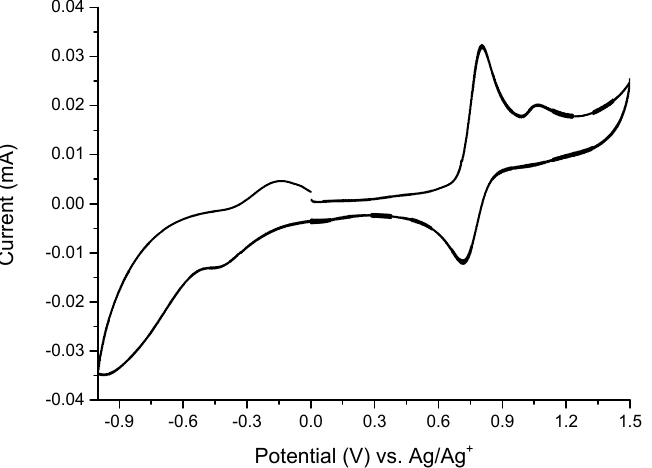
Figure 3. Cyclic voltammogram of complex 1 measured in anhydrous and deaerated acetonitrile with 0.1 M TBAClO 4 as a supporting electrolyte at scan rate 100 mV·s − 1 .